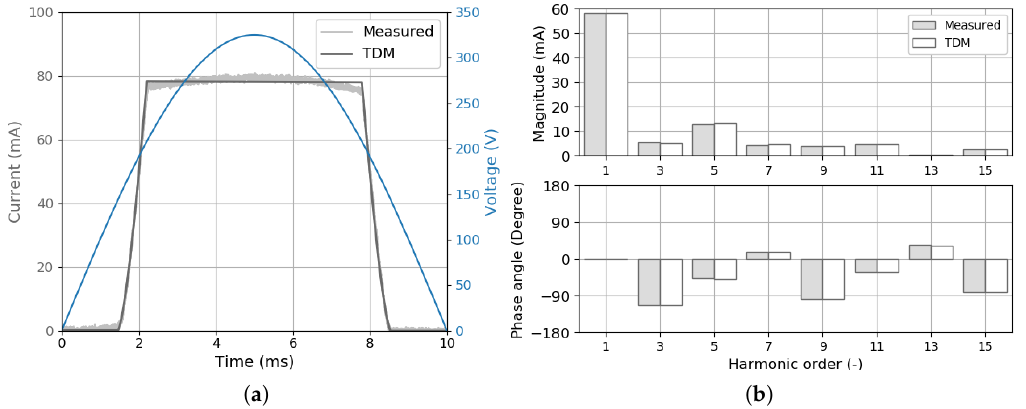
Figure A5. Time domain circuit model of the Type C LED lamp: ( a ) Topology ( b ) constant current regulator control.